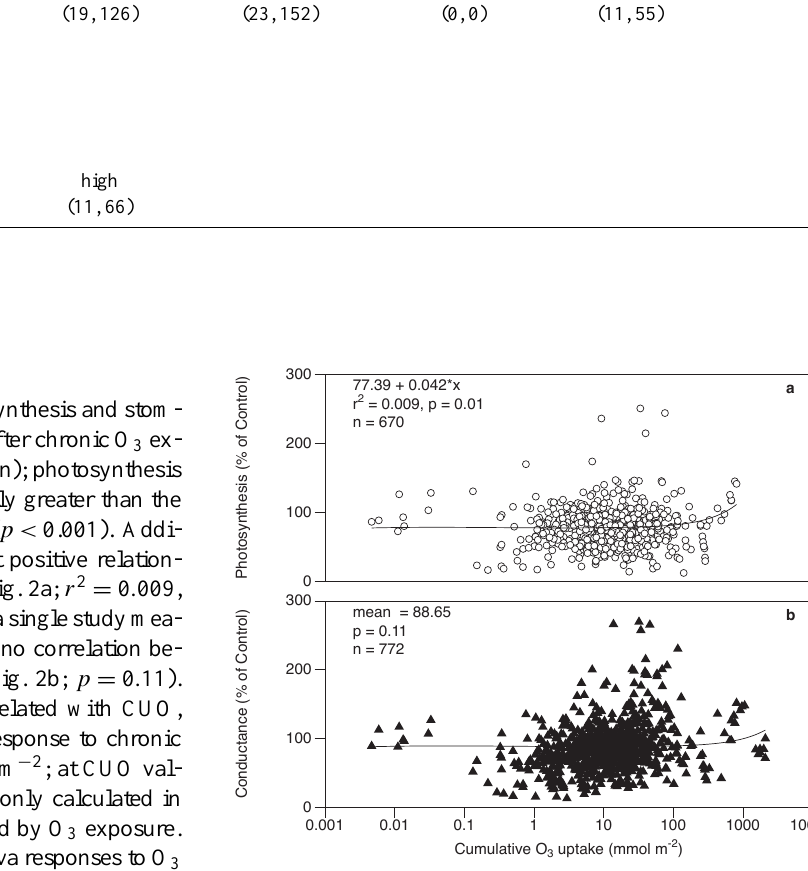
Fig. 2. The correlation of photosynthesis (open symbols; a ) and conductance (closed symbols; b ) to CUO across all plant types, ages, and vulnerabilities for all data. Response values are reported as % of control (treatment/control). CUO is shown on a log scale, but linear analyses ( r 2 and line equations) were performed on non- log transformed data. r 2 values are only included for significant correlations, and n values are the number of data points included in the